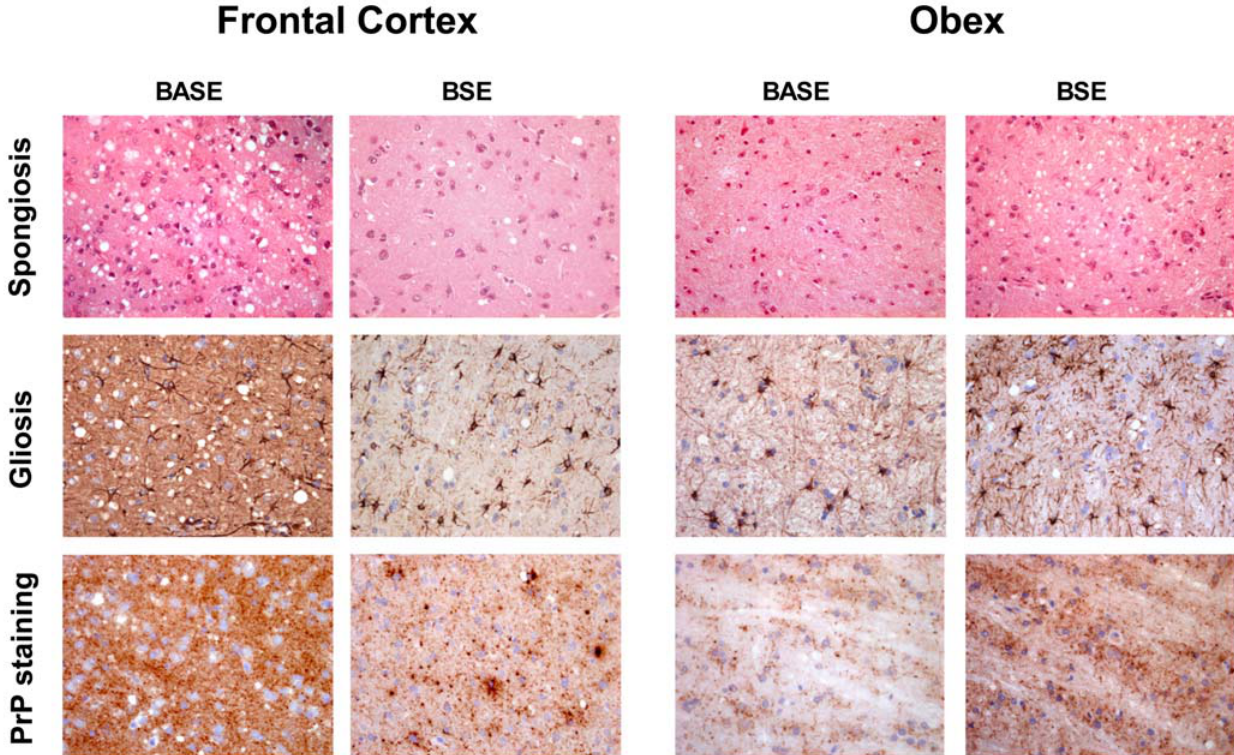
Figure 2. Histopathology and PrPres immunostaining. S pongiosis, gliosis (GFAP staining) and PrPres deposition in frontal cortex and obex in BASE- and cBSE-infected primates (original magnification 6 200 for spongiosis and gliosis, 6 400 for PrPres staining). Immunostaining of PrPres was performed with 3F4 monoclonal anti-PrP antibody after proteinase K treatment as previously described [11]. No staining was observed in the brain of control healthy primates (data not shown) in these conditions.